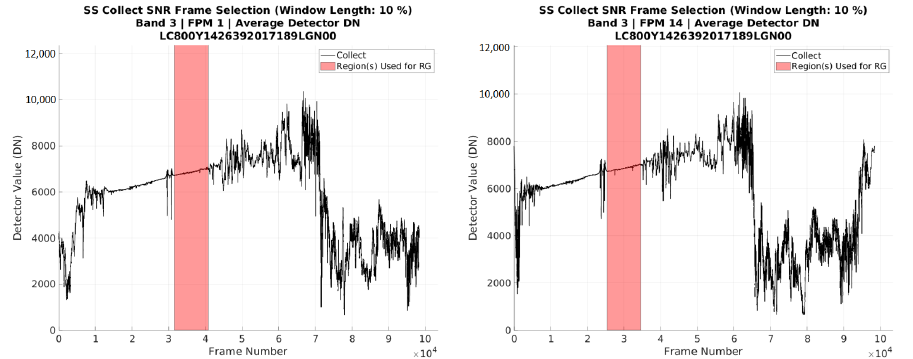
Figure 7. Band 3 FPM 1 region used for relative gains ( left ) compared with FPM 14 region used for relative gain derivation ( right ) from same Greenland side